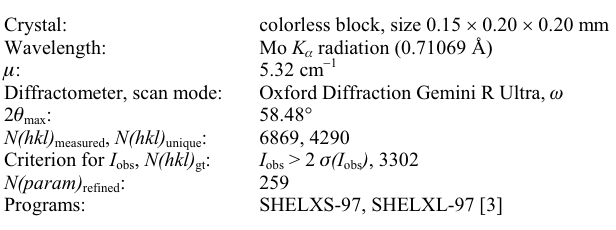
Table 1. Data collection and